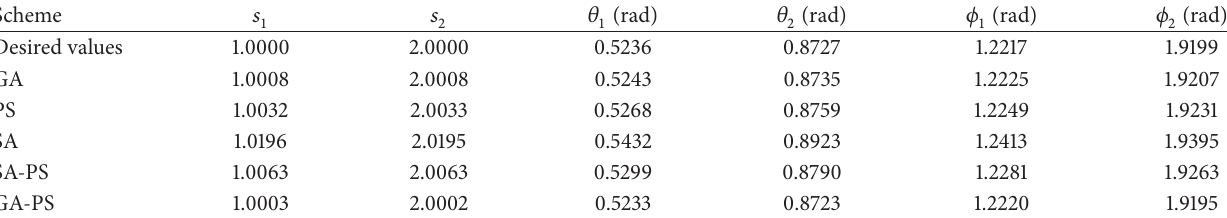
Table 3: Estimation accuracy of 1-L-type array for 2 sources